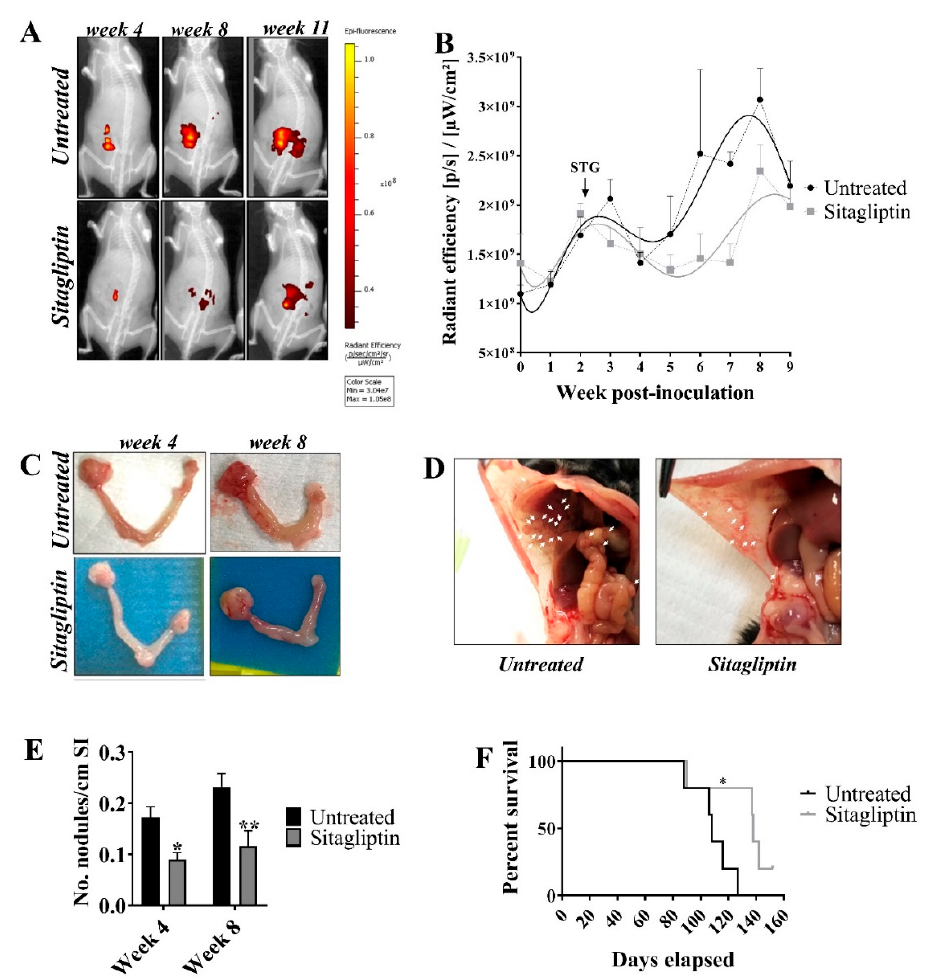
Figure 2. Tumour burden and metastatic spread in ID8 pROSA-iRFP720 tumour-bearing mice following sitagliptin treat ‐ ment. ( A ) ID8 pROSA ‐ iRFP720 cells were implanted into the ovarian bursa and iRFP720 fluorescence was measured using the IVIS Lumina III In Vivo Imaging System (Perkin Elmer, Waltham, MA, USA). Mice were imaged at FOV C ( n = 5–15/group) and iRFP720 fluorescence was detected using the iRFP filter set at an exposure time of 5 s. iRFP signal was isolated using a custom spectral unmixing algorithm. Representative images of iRFP fluorescence are shown. ( B ) Quanti ‐ tative region of interest (ROI) analysis of iRFP total radiant efficiency [p/s]/[ μ W/cm 2 ] over time. ( C ) Representative images of ovaries from untreated mice or mice receiving sitagliptin at weeks 4 and 8 post tumour inoculation. ID8 pROSA ‐ iRFP720 tumours are shown on the right and nontumour bearing ovaries are shown on the left . ( D ) The proportion of macroscopic tumour nodules on the small intestine/length (cm). ( E ) Representative images of tumour nodules on the peritoneal wall from untreated mice and mice receiving sitagliptin treatment. ( F ) The Kaplan ‐ Meier curve and log ‐ rank test of overall survival analysis for ID8 pROSA ‐ iRFP720 tumour ‐ bearing mice. Data are presented as mean ± SD (upper SD for iRFP720 fluorescence). * = p < 0.05; ** = p < 0.01.